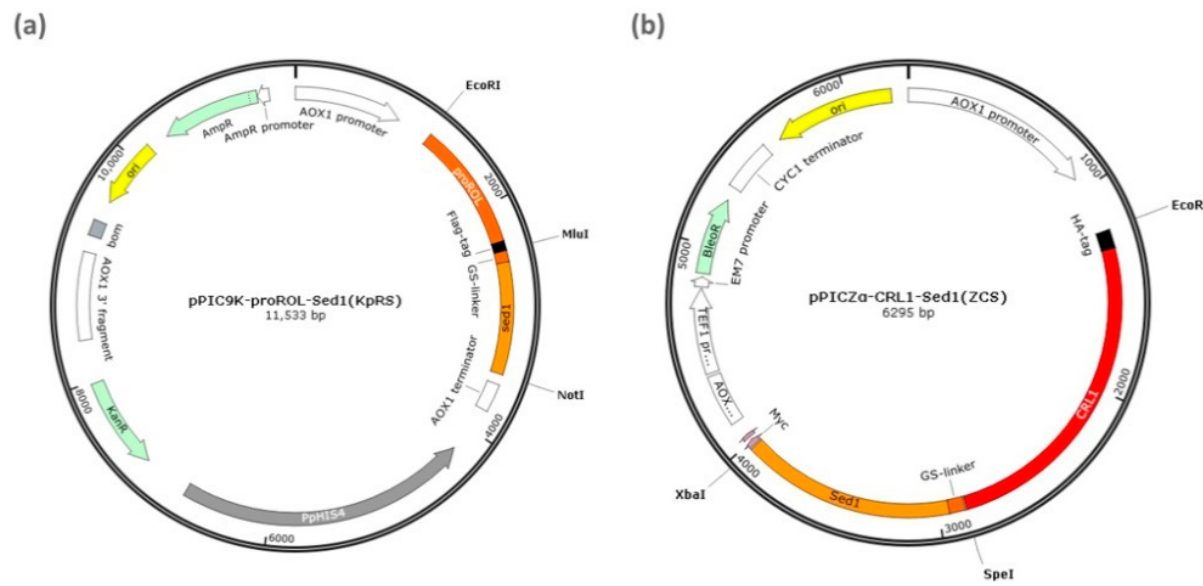
Figure 5. Display plasmids encoding sed -targeted genes. ( a ) pPIC9K-ROL-sed1 (KpRS) encoding Rhizopus oryzae lipase (ROL) and sed1 fusion protein. Flag-tag between proROl and sed1 was used for immunofluorescence detection. ( b ) pPICZ α - CRL1-sed1 (ZCS) encoding Candida rugosa lipase 1 (CRL1) and sed1 fusion protein. The HA peptide at the N -terminal of CRL1 was used in the immunofluorescence analysis.